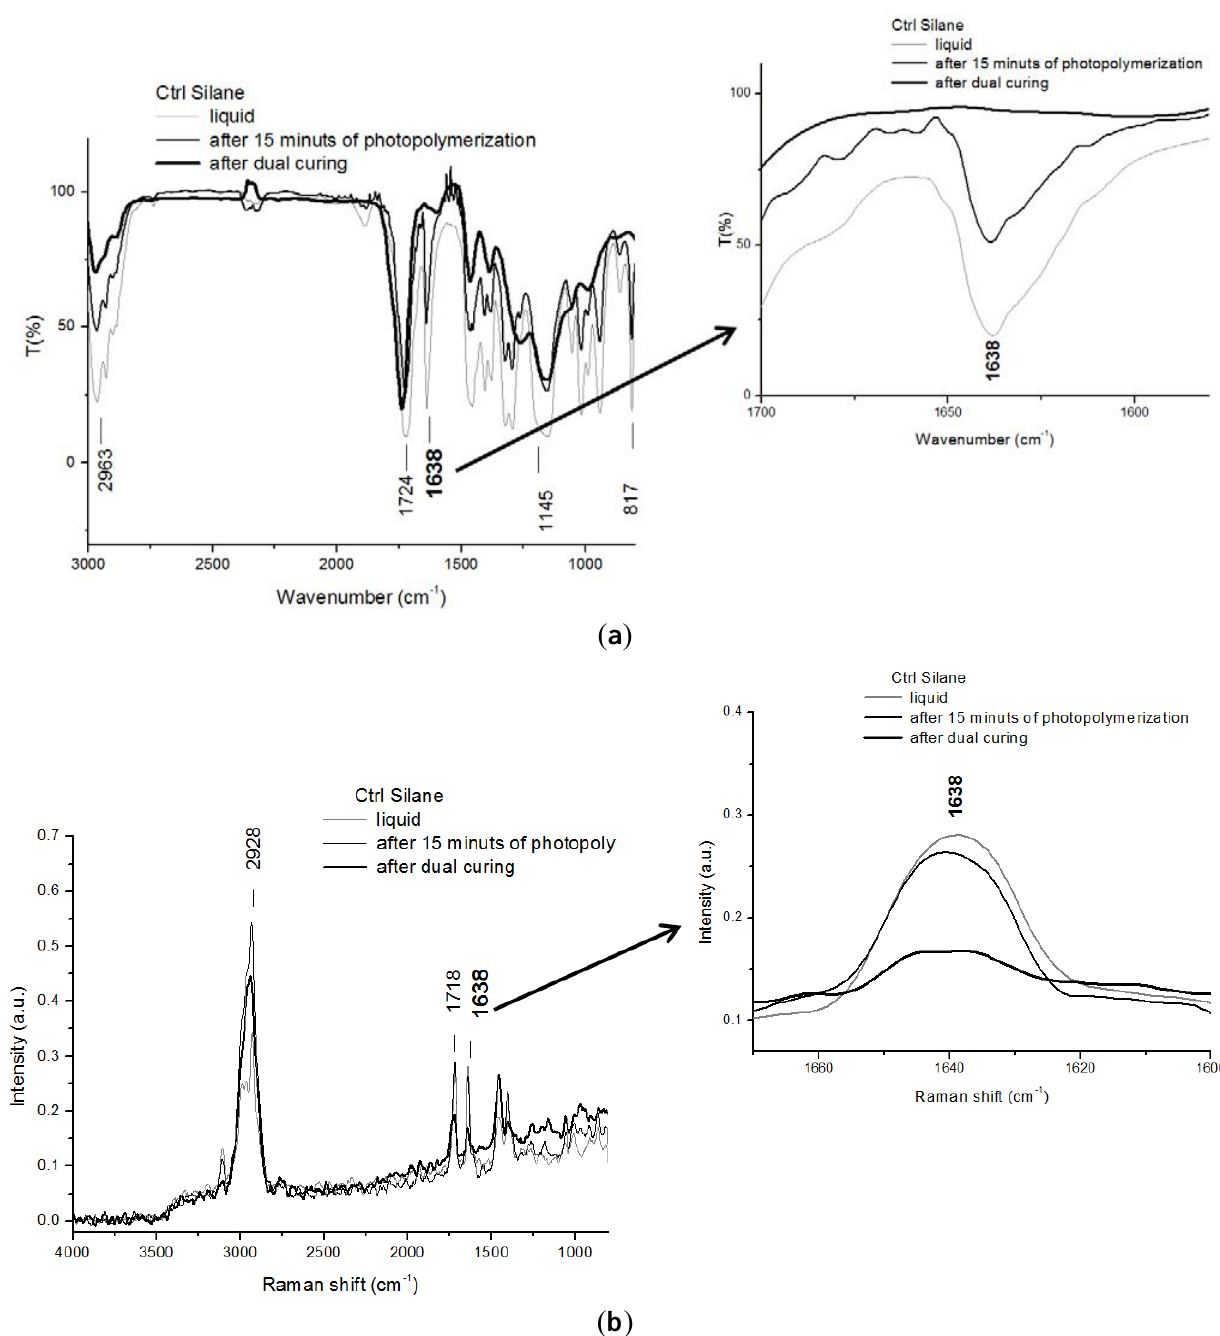
Figure 4. ( a ) Fourier transform infrared (FTIR) spectra of Ctrl Silane formulation at different stages of curing. In the frame on the right, there is enlargement of the peak at 1638 cm − 1 ; and ( b ) Raman spectra of Ctrl Silane formulation at different stages of curing. In the frame on the right, there is enlargement of the peak at 1638 cm − 1